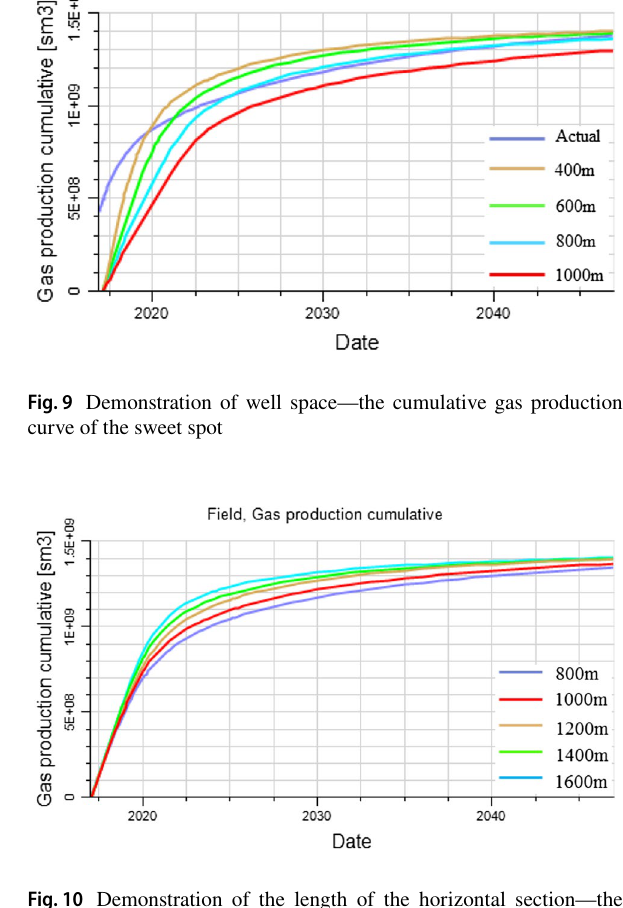
Fig. 10 Demonstration of the length of the horizontal section—the cumulative gas production curve of the sweet spot